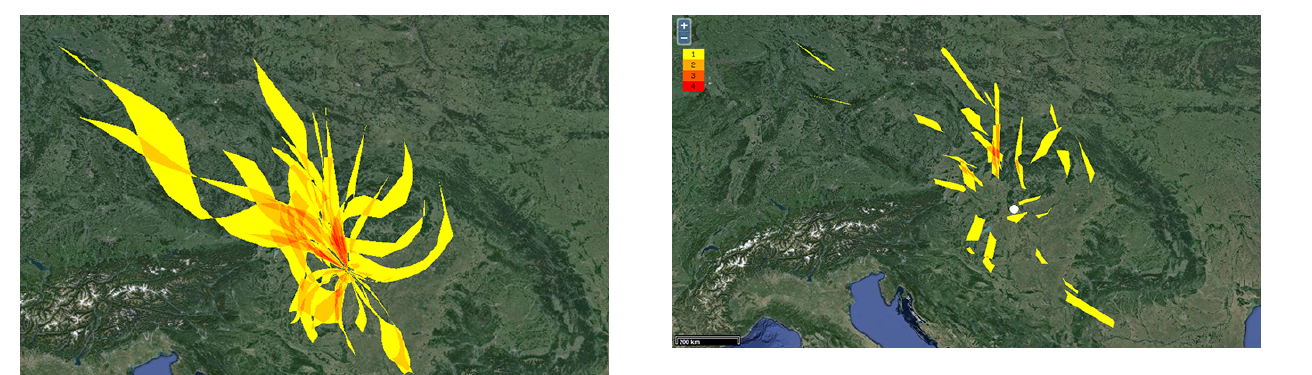
Figure 6. The furthest probable field of nucleating air masses in the Carpathian Basin observable in Budapest (marked by a white dot). The overlapping areas were indicated in stronger shaded colours (from yellow to red), and their multiplicity in overlapping is shown in the upper left